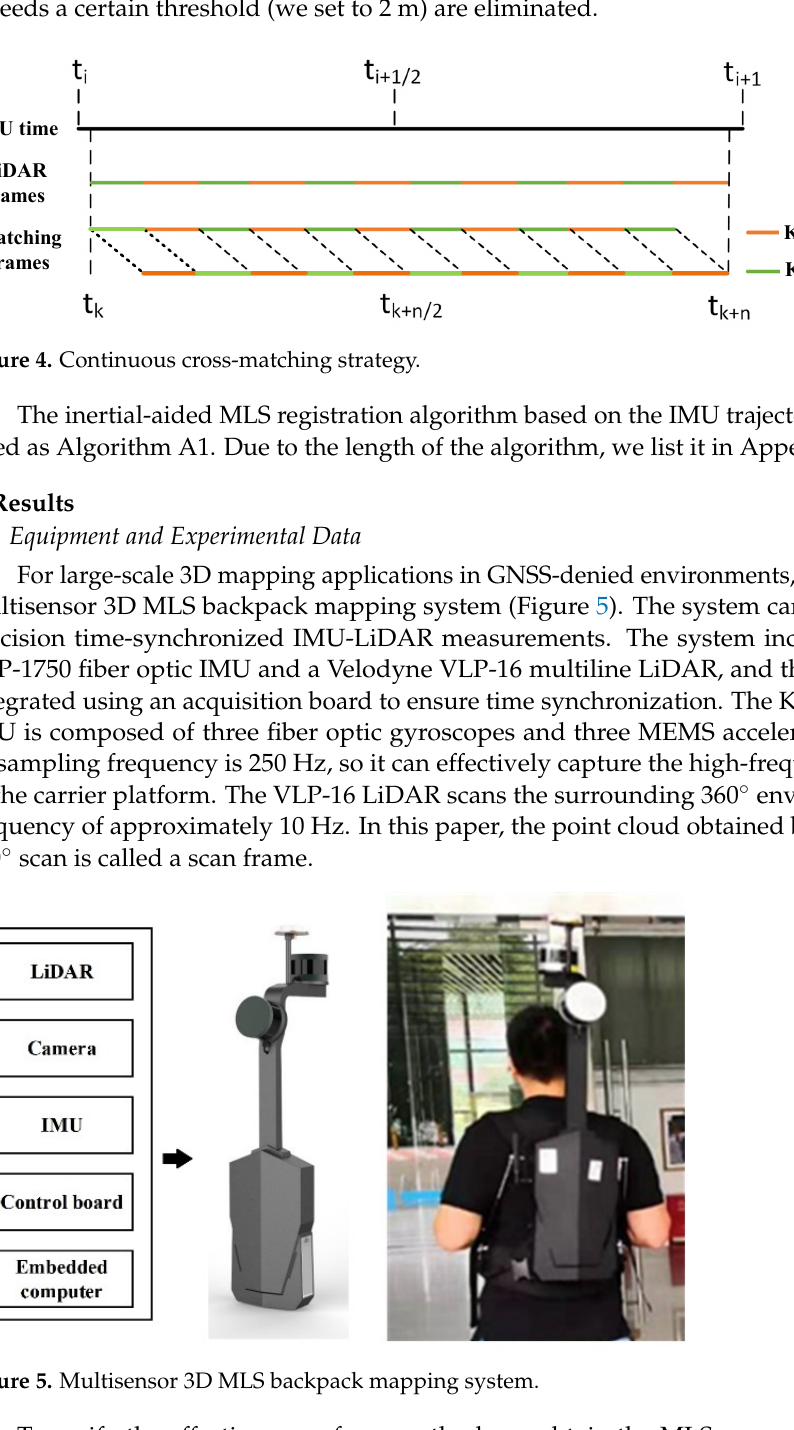
Figure 4. Continuous cross-matching strategy.